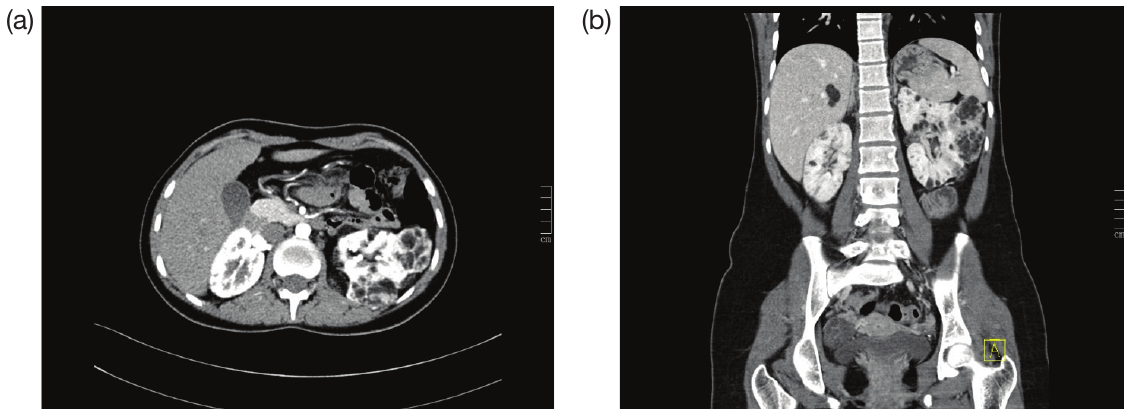
Figure 2: Contrast enhanced CT images of abdomen in axial (a) and coronal (b) planes. This is the case of a 16-year-old female with tuberous sclerosis undergoing treatment with everolimus. The CT scan shows right heminephrectomy and an enlarged left kidney with multiple cysts and